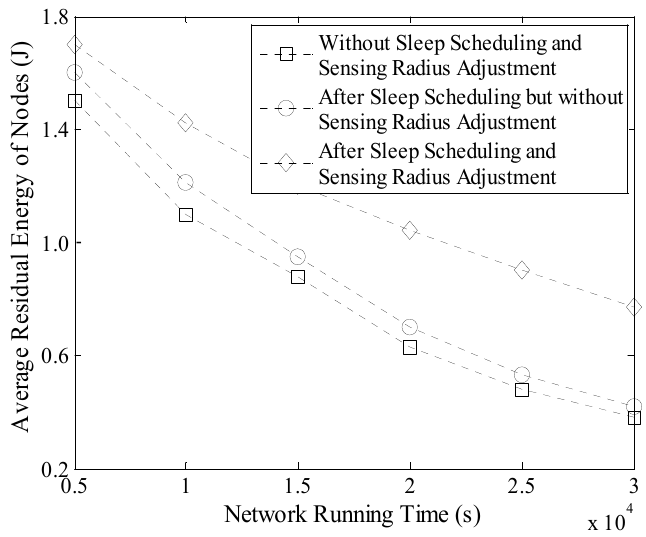
Figure 19. Average residual energy of nodes (100 m × 100 m, 500 nodes).